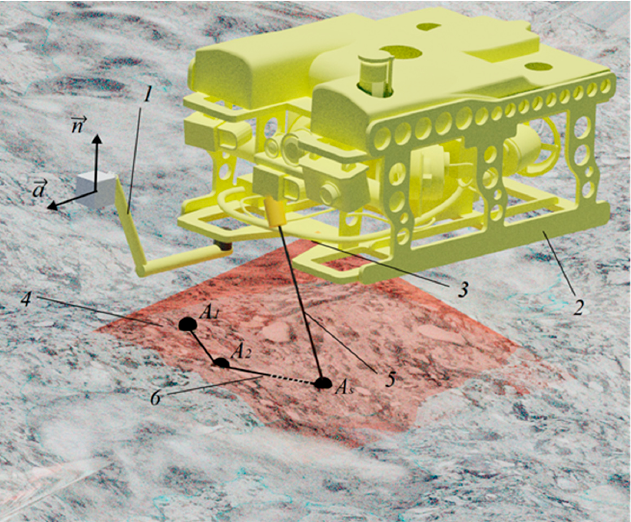
Figure 3. An operation performed in the supervisory